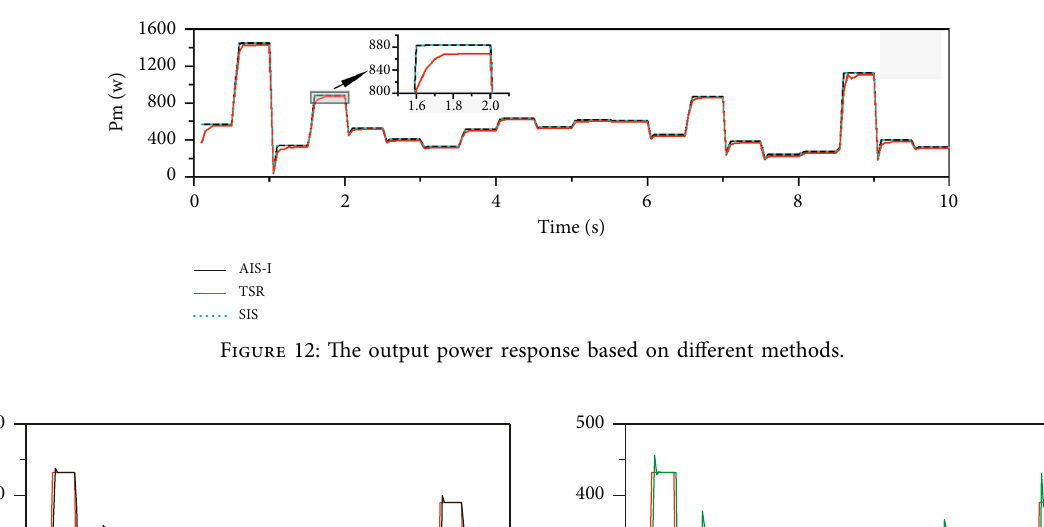
Figure 11: Power coefficient C on the SVR method.